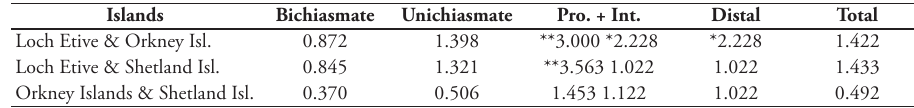
Table 2. Pairwise comparisons for chiasma mean numbers between individuals from the three Scottish sites of Chrysolina latecincta ssp. intermedia . pro. = proximal, int. = interstitial. Islands Bichiasmate Loch Etive & Orkney Isl. Loch Etive & Shetland Isl. Orkney Islands & Shetland